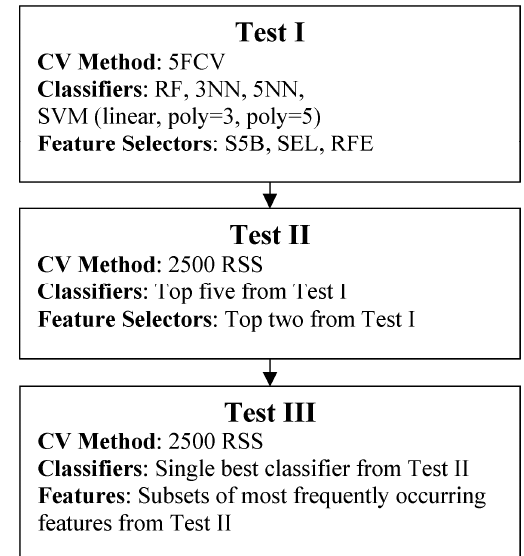
Figure 3. Model performance evaluations.